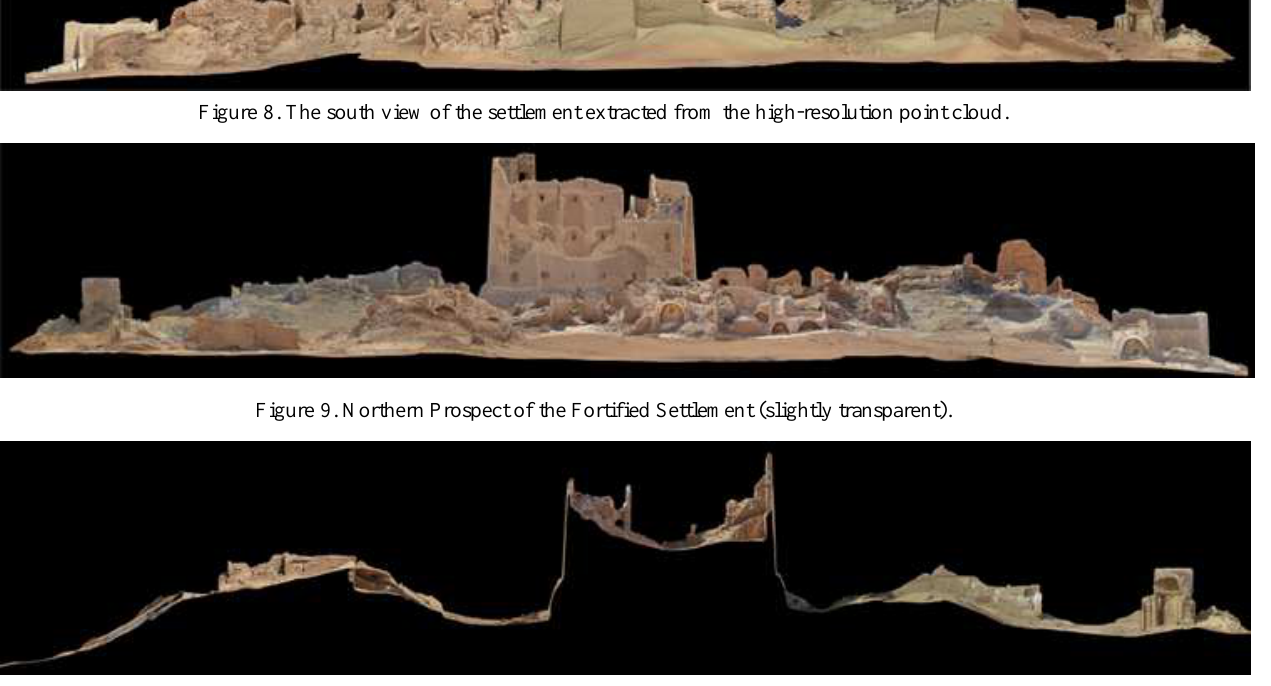
Figure 10. East-West Section of the Fortified